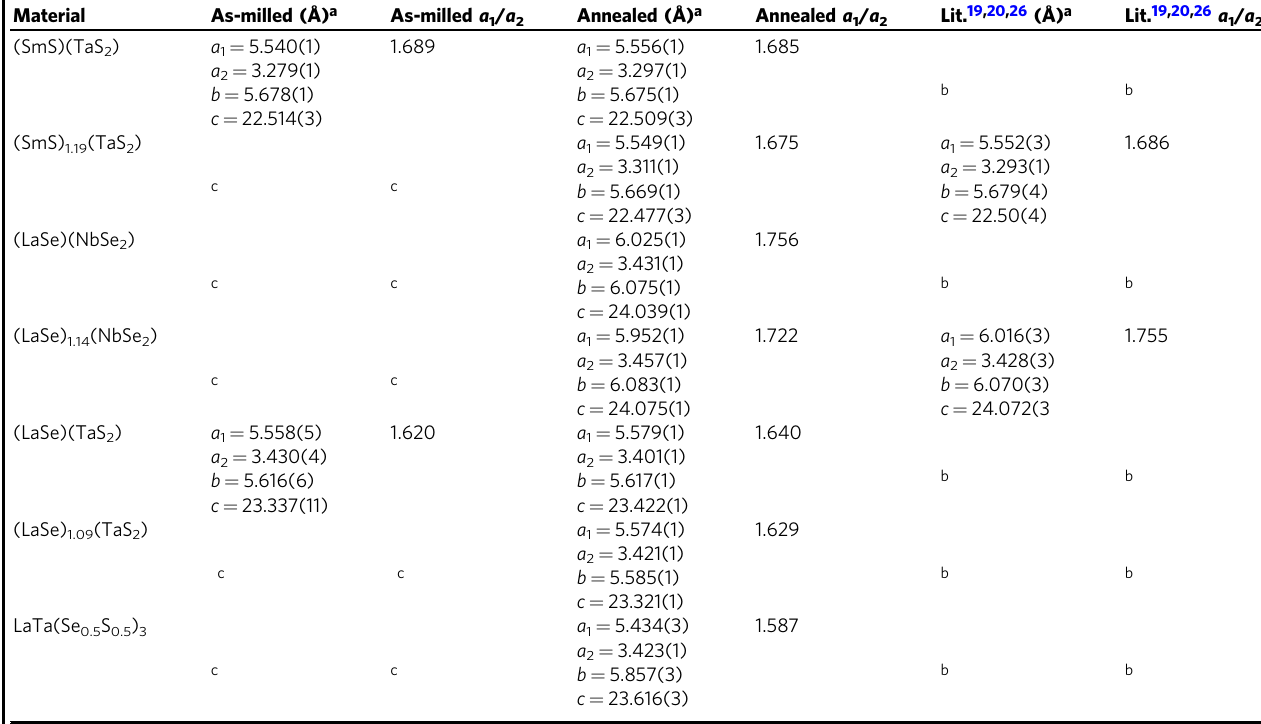
a Lattice parameters; standard deviations are given within parentheses. b Data are unavailable. c Structure is not re fi ned due to strong peak broadening.